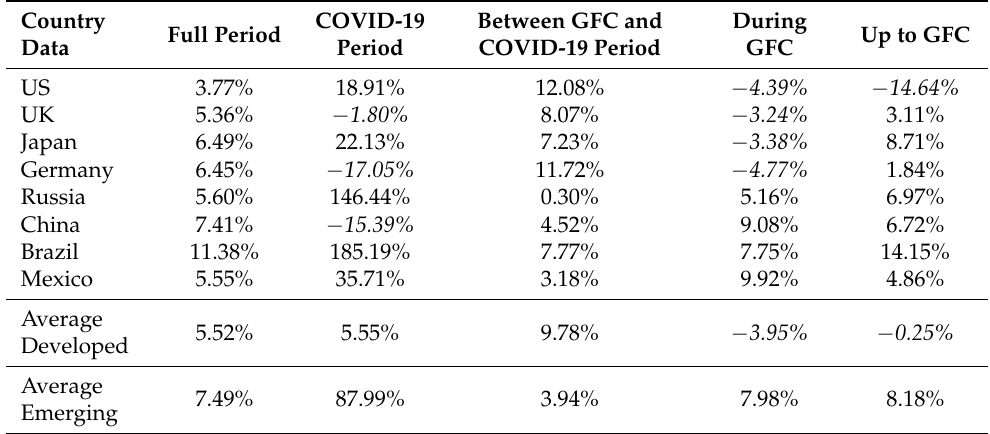
Table 3. Fama French three-factor model—results of cost of equity calculations for developed and emerging countries; negative values in